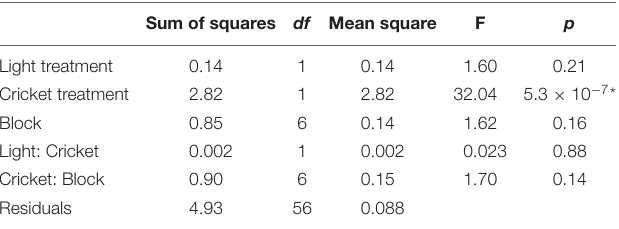
TABLE 3 | ANOVA table showing the effects of light treatment, cricket treatment, and block (plus interactions between light and cricket treatment and cricket and block treatment) on daily percent change in grass height between day 21 and the end of the